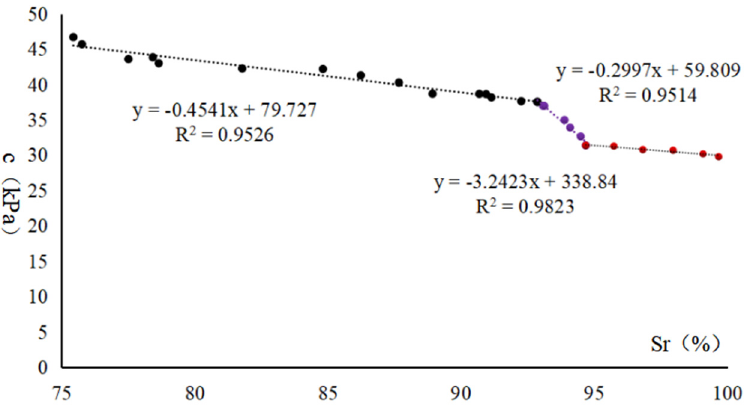
Figure 2. Relationship between humidity and cohesion c.